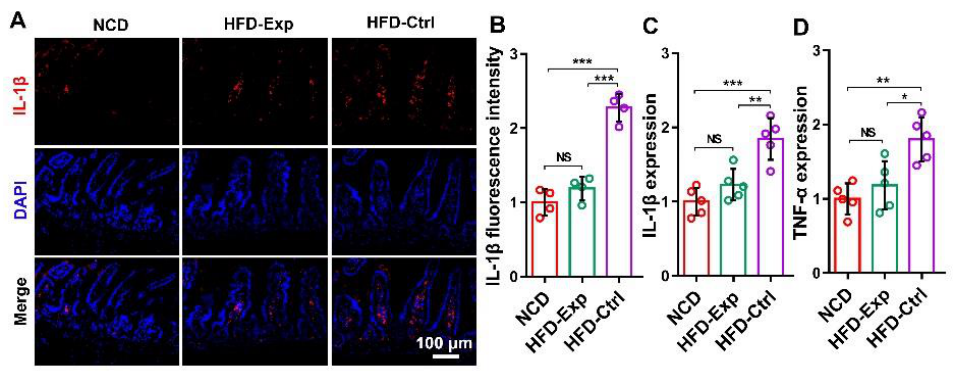
Figure 2. IL-1 β shRNA/yeast inhibits IL-1 β expression in small intestine and intestinal macrophages. ( A ) Immunofluorescence staining of IL-1 β (red) in small intestine. DAPI nuclear staining (blue) was also conducted. ( B ) Quantification of IL-1 β fluorescent signal in the small intestine ( n = 4). ( C , D ) The expression of IL-1 β and TNF- α in intestinal macrophage ( n = 5). NS (no significance). * p < 0.05, ** p < 0.01, *** p <